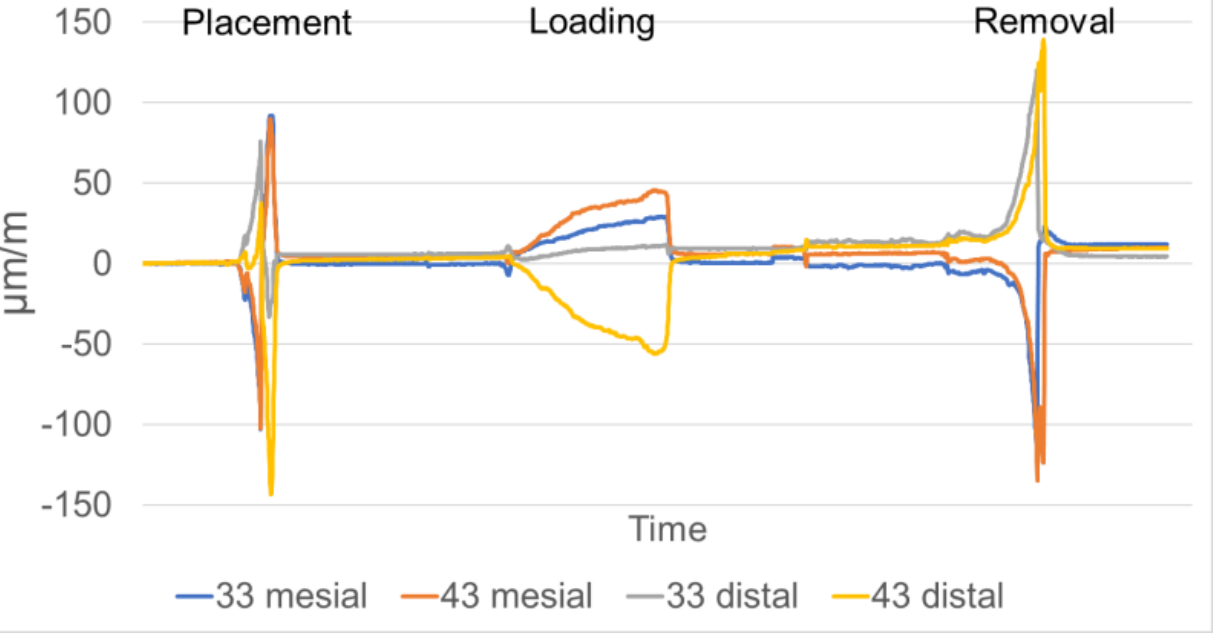
Figure 5. Strain development recorded at the peri-implant sensors (named according to their position relative to the implants: 33 mesial, 33 distal, 43 mesial, 43 distal) during seating, loading and removal of a specific prosthesis .